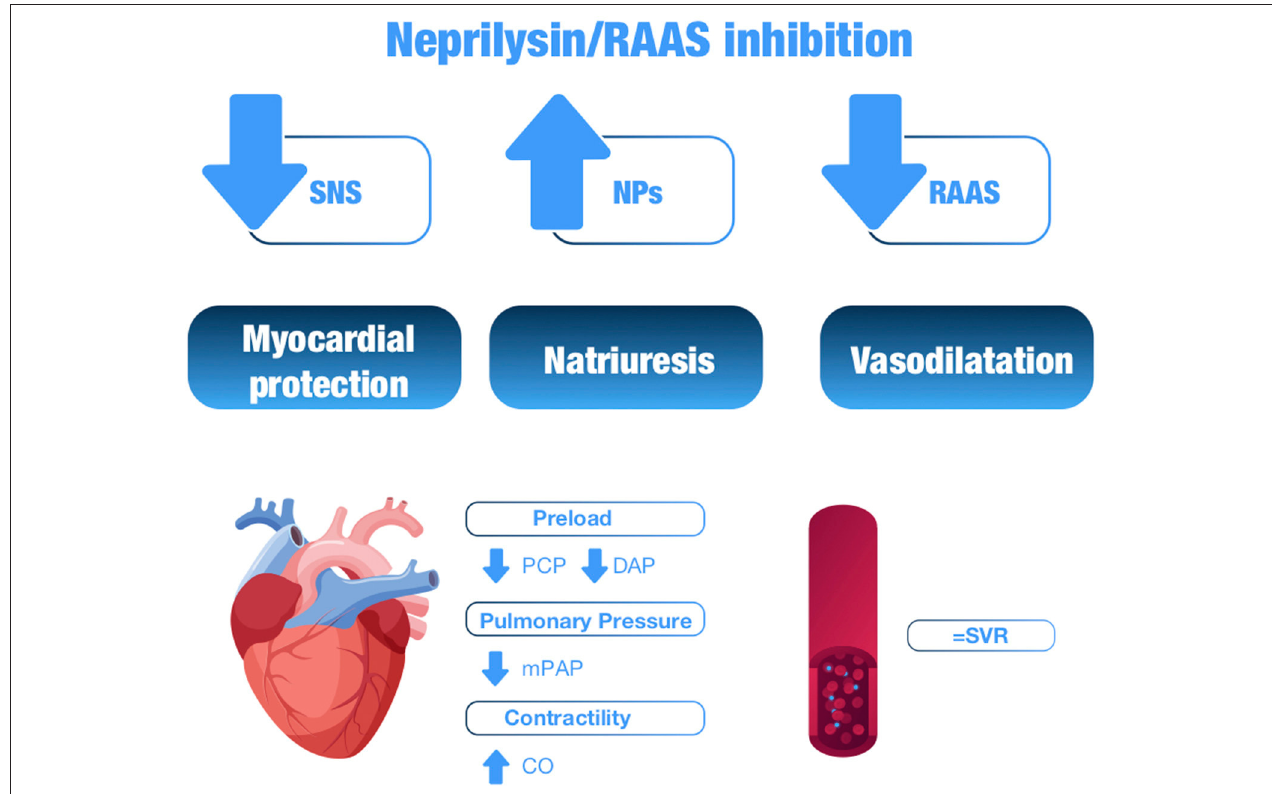
FIGURE 4 | Summary of the hemodynamic effects of neprilysin/RAAS inhibition. SNS, sympathetic nervous system; NPs, natriuretic peptides; RAAS, renin-angiotensin-aldosterone system; PCP, pulmonary capillary pressure; DAP, diastolic arterial pressure; mPAP, mean pulmonary arterial pressure; CO, cardiac output; SVR, systemic vascular